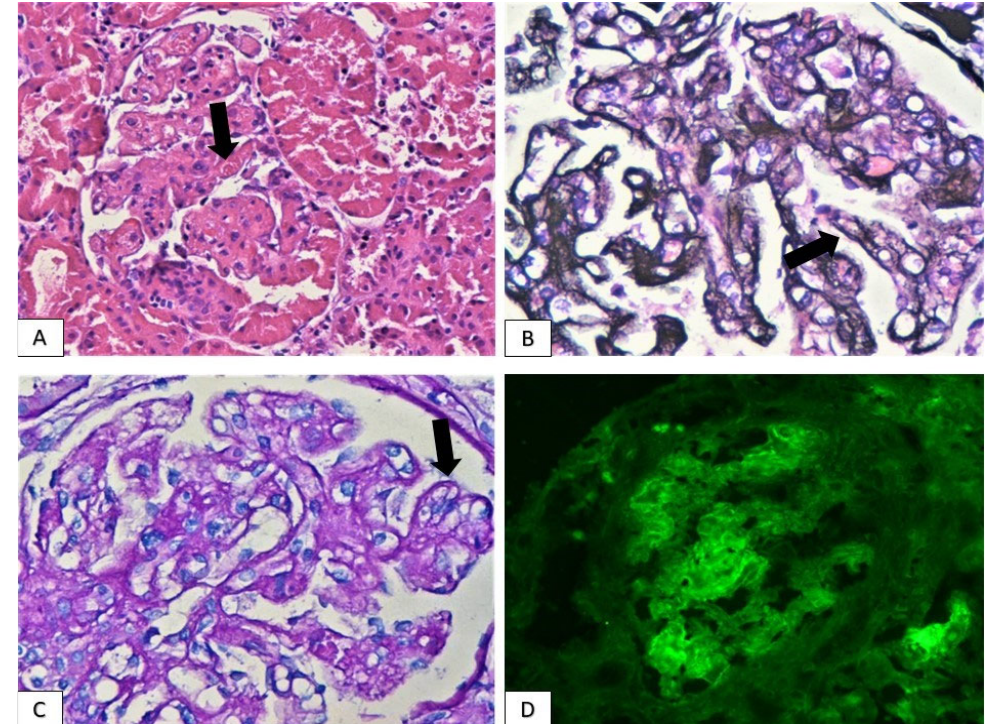
Figure 4. Glomerulus with intraglomerular fibrin thrombus (arrow, ( A ): H&E ×400) and segmental double contours of glomerular basement membranes (arrows, ( B ): silver ×400 and ( C ): pas ×400). (( D ): immunofluorescence showing IgG deposits along glomerular basement membranes and mesangium, ×400).